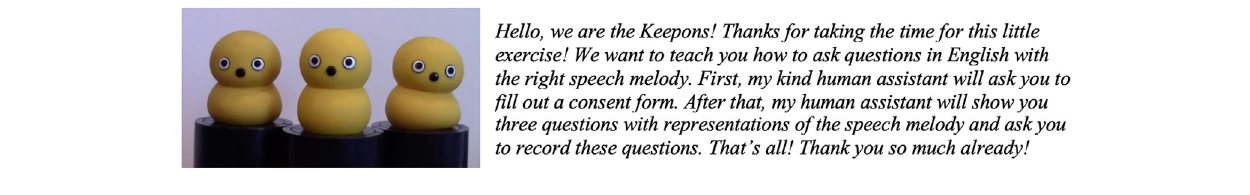
Frontiers in Robotics and AI |